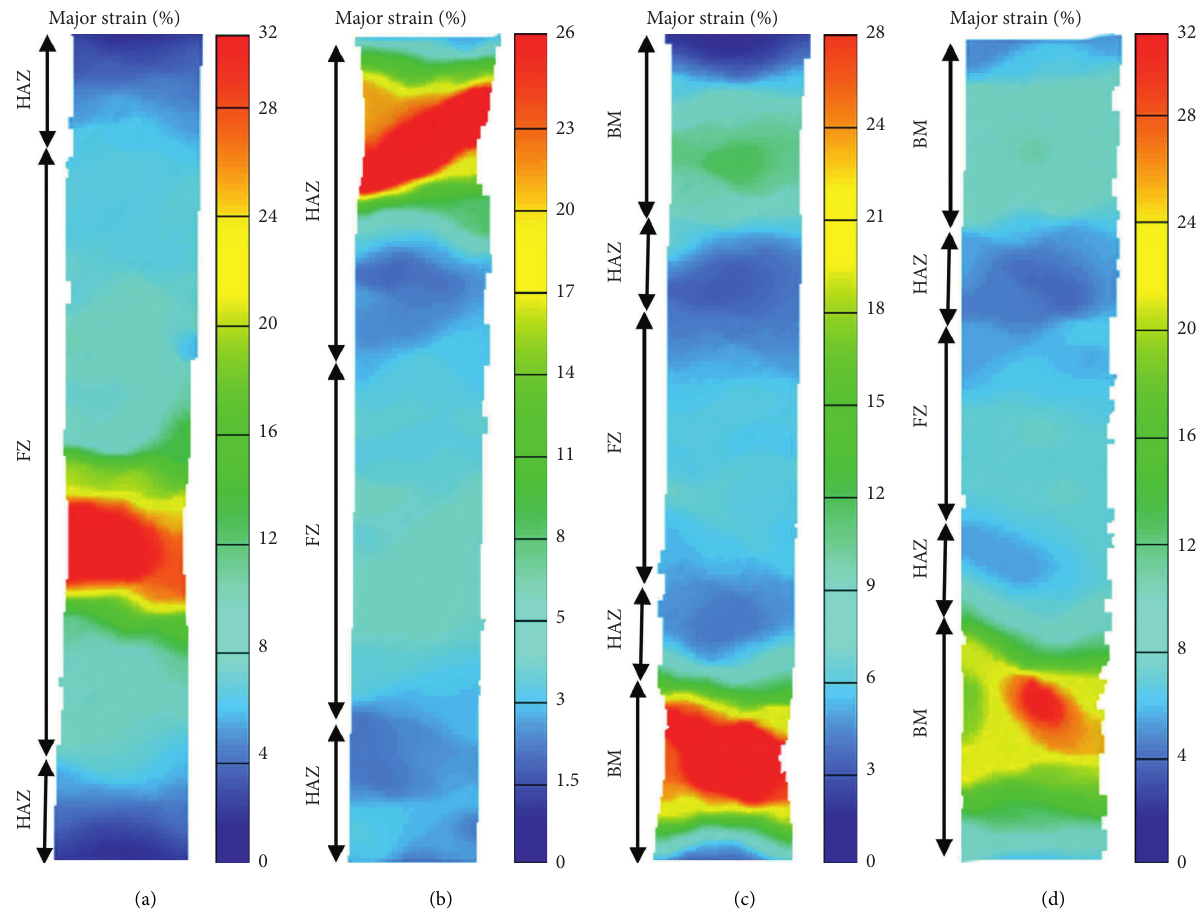
Figure 8: Strain distribution maps before rupture in transverse tensile samples: (a) T1; (b) T2; (c) T3; (d) Table 4: Comparison of the tensile properties and failure locations for PWHTed CA6NM and UNS S41500 ∗ . Process Material Thickness (mm)